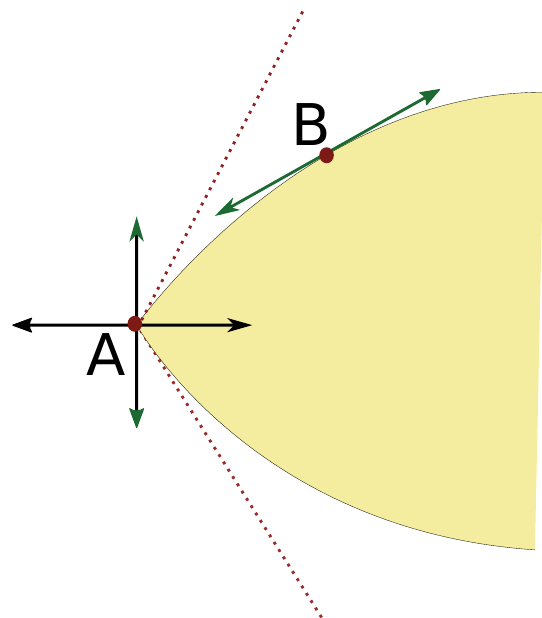
Figure 2. Schematic representation of the convex space of allowed S-matrices. The non-linear sigma model is at a vertex like A where there are no directions such that at the linearized level satisfy the constraints in both directions. At a point like B there are tangents that are parallel to the boundary and appear as zero modes of the linearized constraints. The dotted lines represent the linearized constraints described by V C (cid:24) B (cid:20) B